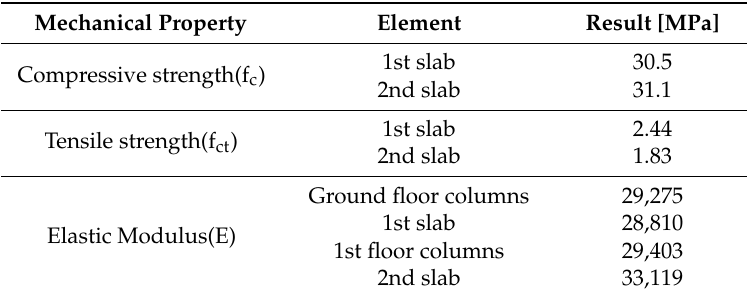
Table 1. Mechanical properties of concrete for columns and